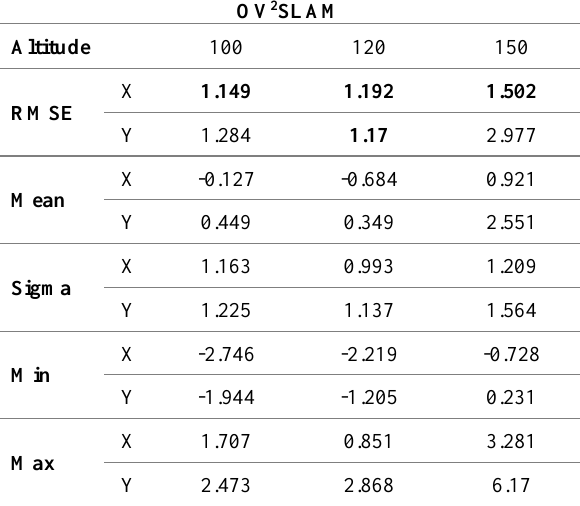
Table 8 Absolute accuracies of the orthomosaic processed with OV 2 SLAM as the underlying framework. Entries in bold are the lowest RMSE among the OpenREALM results in that dimension.